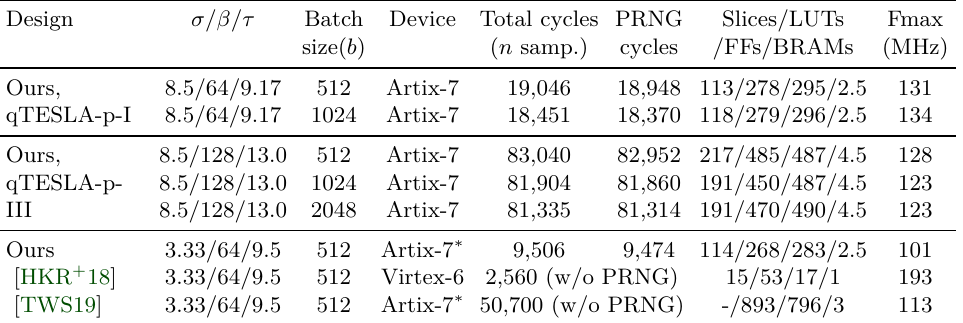
Table 4: Performance of the GaussSampler module and comparison with state-of-the-art related work. The synthesis results for our and related work exclude the PRNG overhead. The “total cycles” in [HKR + 18,TWS19] excludes the PRNG, whereas our work does include it. Results for Artix-7 with ∗ correspond to the device model XC7A100TCSG324, otherwise they correspond to